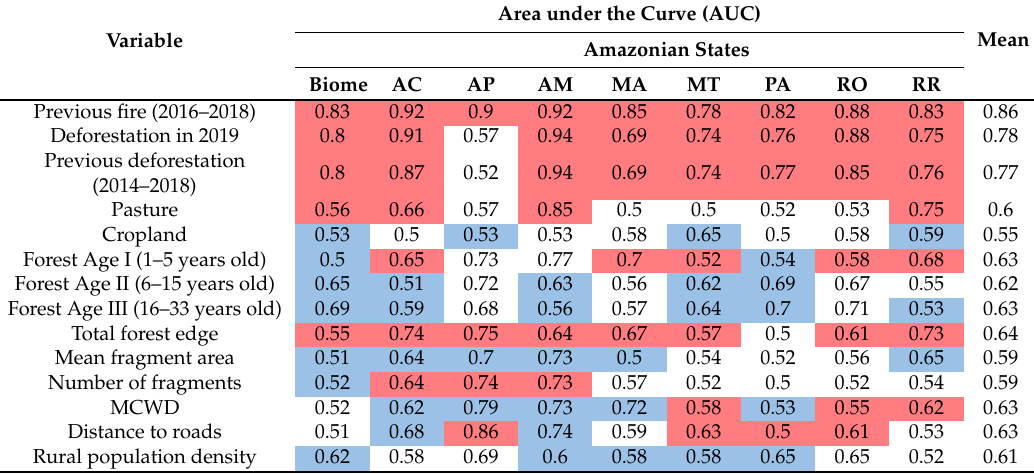
Table 2. The area under the curve (AUC) for each driver, with respect to their ability to discriminate cells with across-grid anomalous fire occurrence from cells with non-anomalous fire occurrence in 2019, for the biome in general and for Amazonian states. AC refer to Acre, AP to Amap á , AM to Amazonas, MA to Maranh ã o, MT to Mato Grosso, PA to Par á , RO to Rond ô nia, and RR to Roraima. Values filled in red indicate that anomalous cells had a greater mean than non-anomalous cells, based on Welch’s t-test, at the 5% significance level. Values filled in blue indicate a significant lower mean for anomalous cells, and no significant di ff erence was found for values in